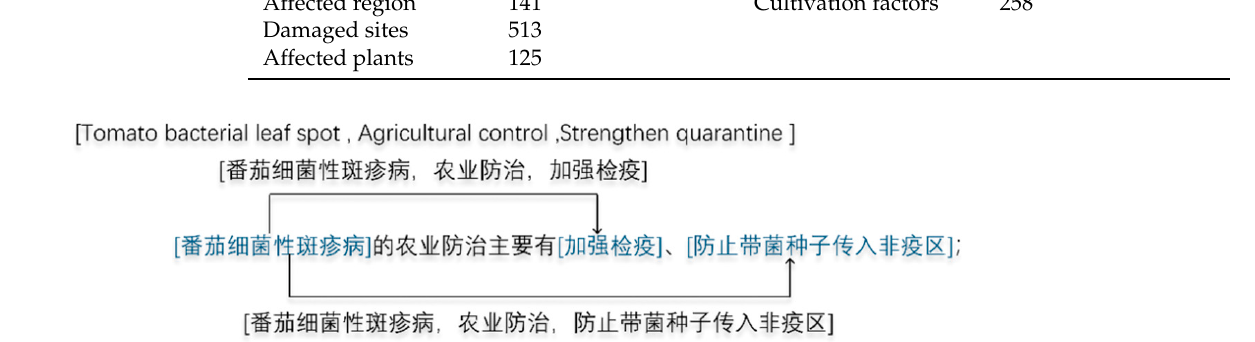
Figure 6. An example of named-entity recognition labeling. Example “ 黄瓜白粉病主要危害叶片, 也 危害叶柄和茎 ” (this means that the cucumber powdery mildew mainly harms the leaves, as well as the petioles and stems.).